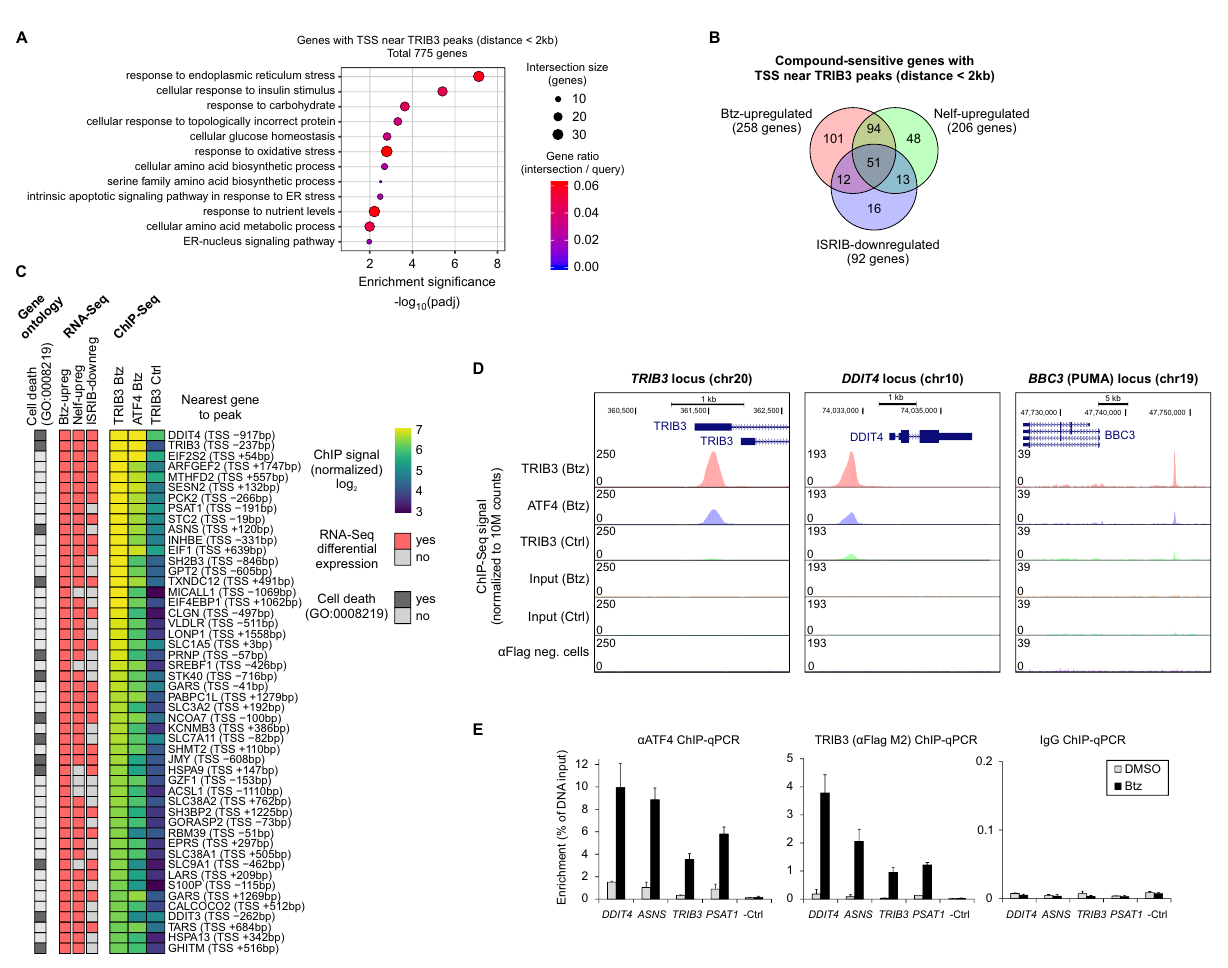
Figure 7. TRIB3 and ATF4 binding near genes that are regulated in response to bortezomib (Btz), nelfinavir (Nelf) and ISRIB in HepG2 cells. ( A ) Gene ontology enrichment analysis for genes with a TRIB3 ChIP-Seq peak within 2 kb of the transcription start site (TSS). The GO Biological Process database was used. ( B ) RNA-Seq differential expression results overlap with genes harboring TRIB3 ChIP-Seq peaks (TSS ± 2 kb). ISRIB-downregulated genes were obtained comparing ISRIB and Btz co-treatment to Btz alone. ( C ) Btz-upregulated genes with TSS-proximal (TSS ± 2 kb) TRIB3 ChIP-Seq peaks. Genes are ranked by the TRIB3 Btz ChIP-Seq signal strength. ( D ) ChIP-Seq coverage plots for selected loci. The α Flag neg. cells track represents ChIP-Seq of unedited HepG2 cells with anti-Flag antibody. ( E ) ChIP-qPCR validation for the binding of ATF4, TRIB3 (anti-Flag M2) and non-targeting IgG at selected loci detected in ChIP-Seq. A negative control locus is also shown (-Ctrl). The means ± SD of 2–5 ChIP experiments from two biological replicates are shown. The DNA quantity is presented as a percentage of input